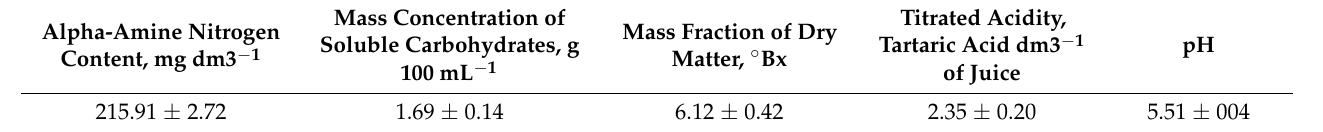
Table 2. Chemical parameters of Sosnovsky hogweed juice.